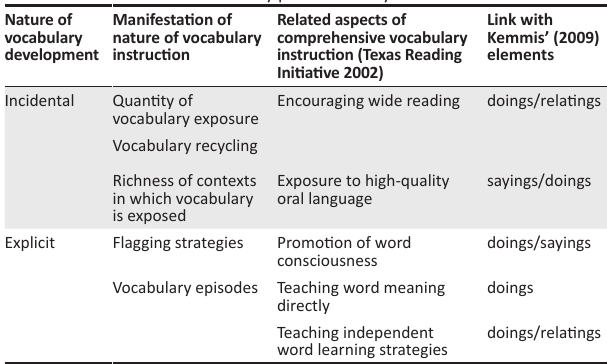
TABLE 1: Framework for vocabulary practices